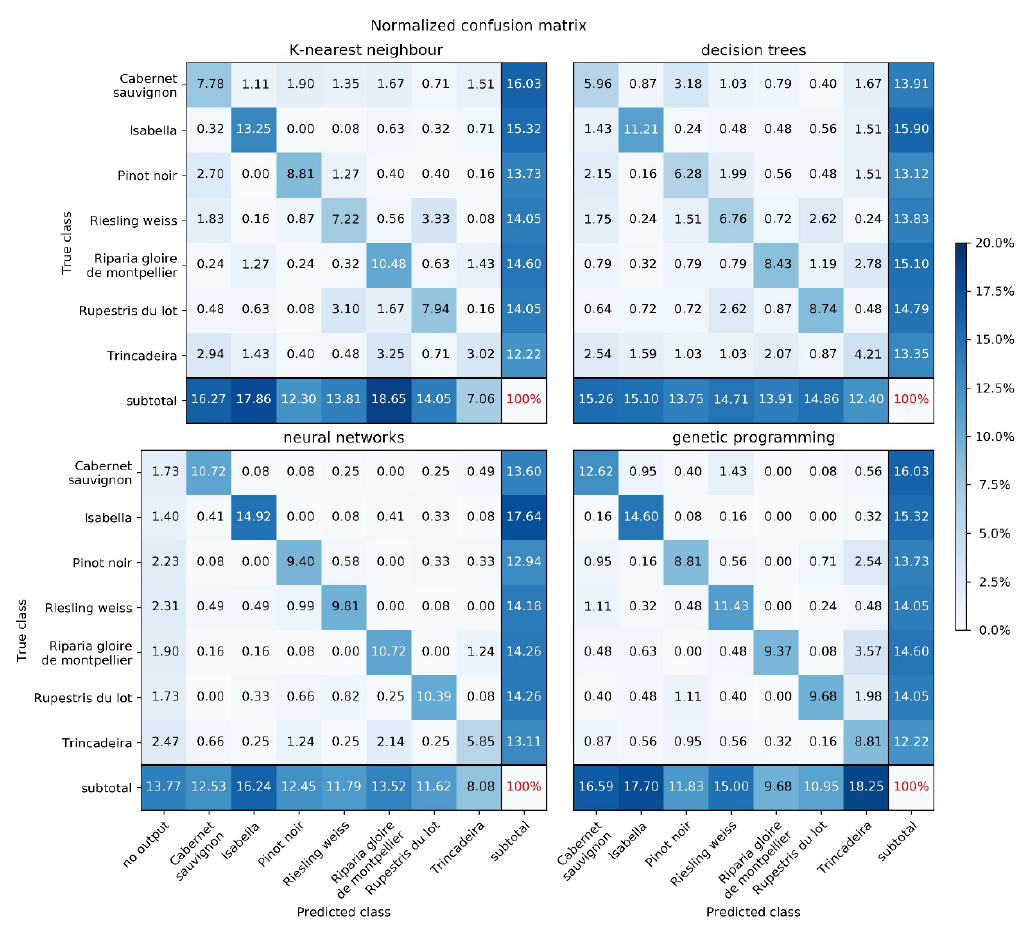
Figure 3. Confusion matrices for all the methods, using the parameterizations specified in Table 1.